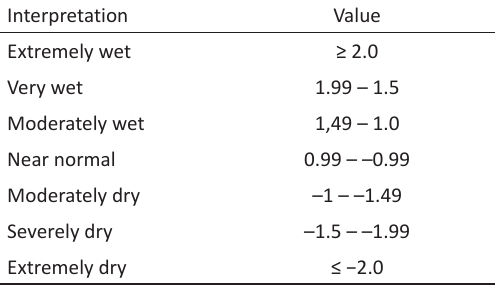
Table 1. SPI, SPEI and EDI interpretation (WMO